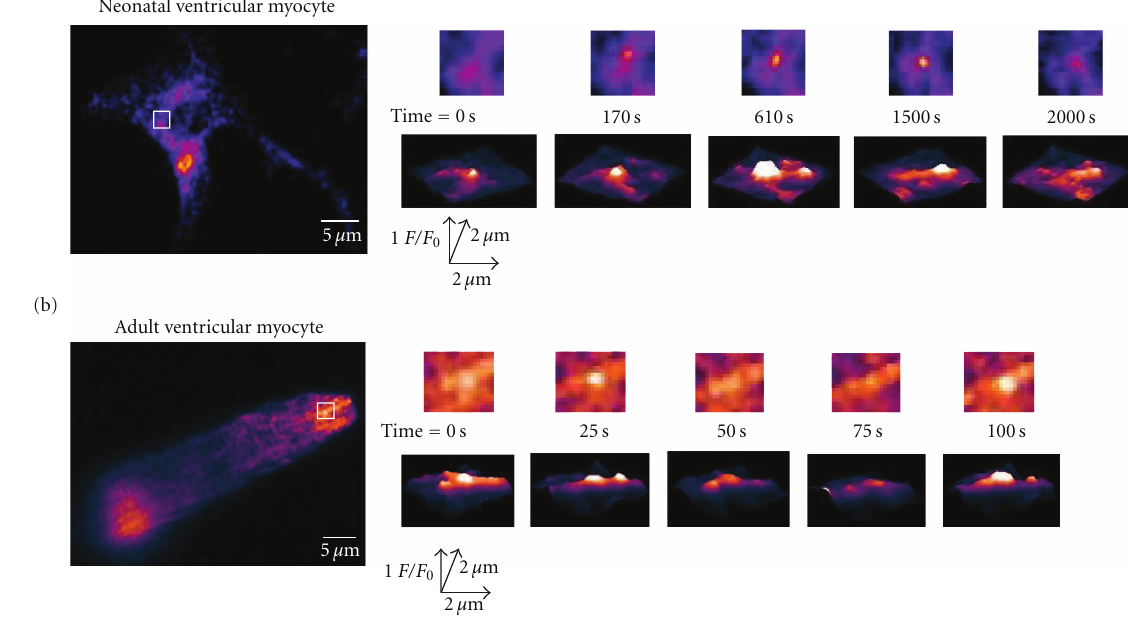
Figure 5: TIRF imaging of submembrane SR motility in neonatal and adult ventricular myocytes. (a) TIRF images of representative neonatal ventricular myocyte expressing tRFP-SR. (b) TIRF image of representative adult ventricular myocyte expressing tRFP-SR. Images to the right are two dimensional images (top row) and surface plots of the region delineated by the